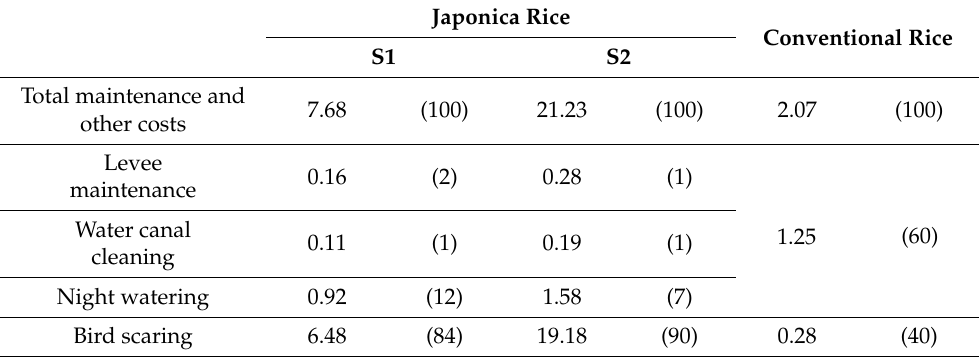
Table 5. Comparison of “maintenance and other costs” between japonica rice and conventional rice (unit: